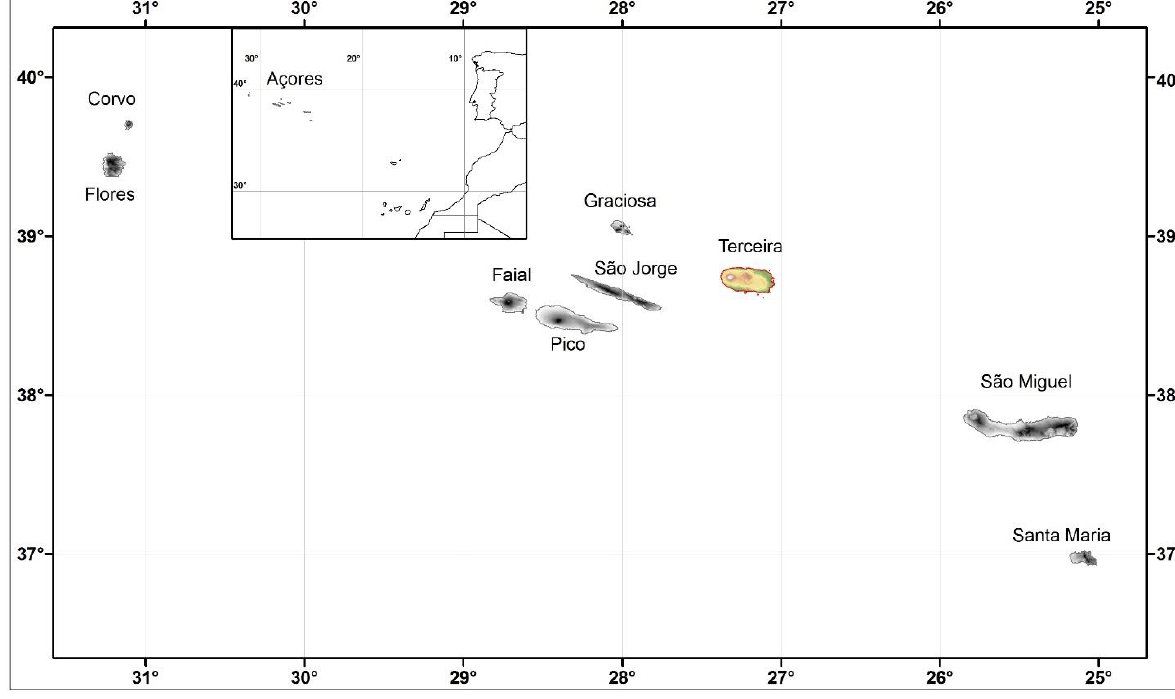
Figure 1. Map showing the Azores archipelago and its location within the North Atlantic region (inset). Terceira is the island studied